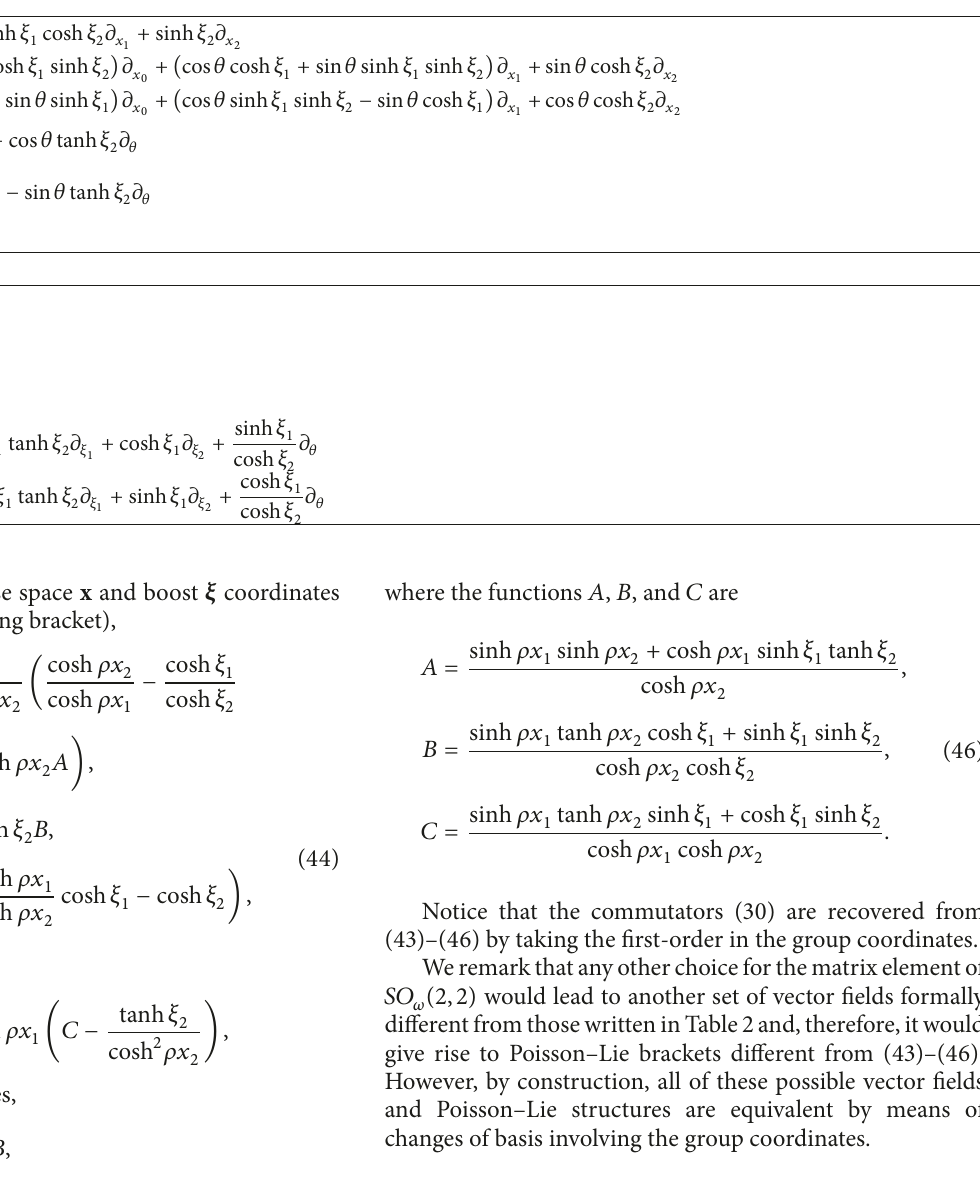
Table 3: Left- and right-invariant Poincar´e vector fields with 𝜔 = 𝜌 = Λ = 0 . Left-invariant vector